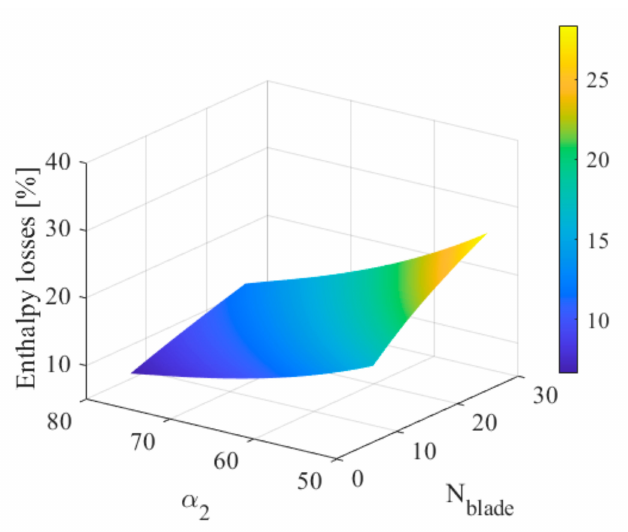
Figure 12. Variation of the power with α 2 and number of blades.